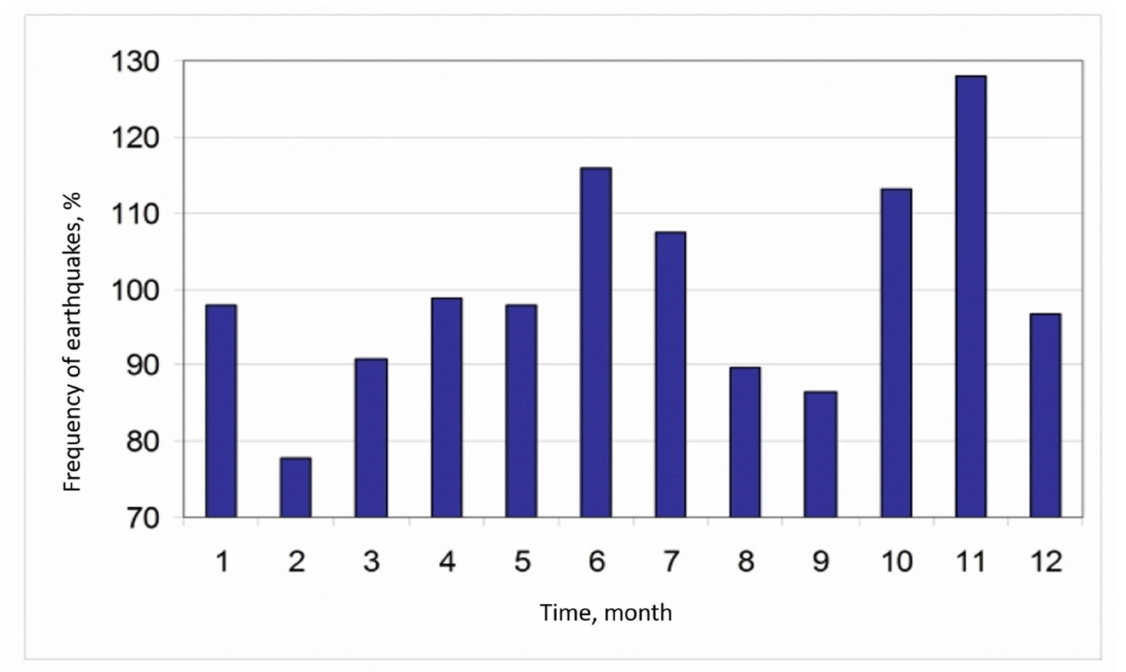
Figure 23. Analysis results for solar–terrestrial relations with regard to earthquakes occurring. Seasonal changes in earthquake frequencies of more than magnitude 7 for 1900–2004, in comparison to the average value percentage (%) over 2659 events for each 20-yr period. Months 6–7 and 10–11 of the year are usually the most dangerous for the occurrence of catastrophic floods.